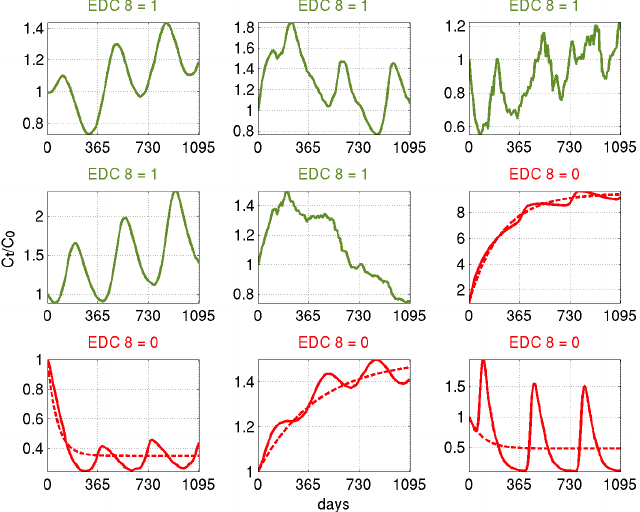
Figure 1. Exponential decay test (EDC 8) performed on nine example normalized C pool trajectories over a 3yr time span. The C pool trajectories are normalized such that C pool = 1 at t = 0. Examples 1–5 were accepted (EDC 8 = 1) and examples 6–9 were rejected (EDC 8 = 0). The exponential decay fit (dashed line) is shown for pool trajectories where EDC 8 =